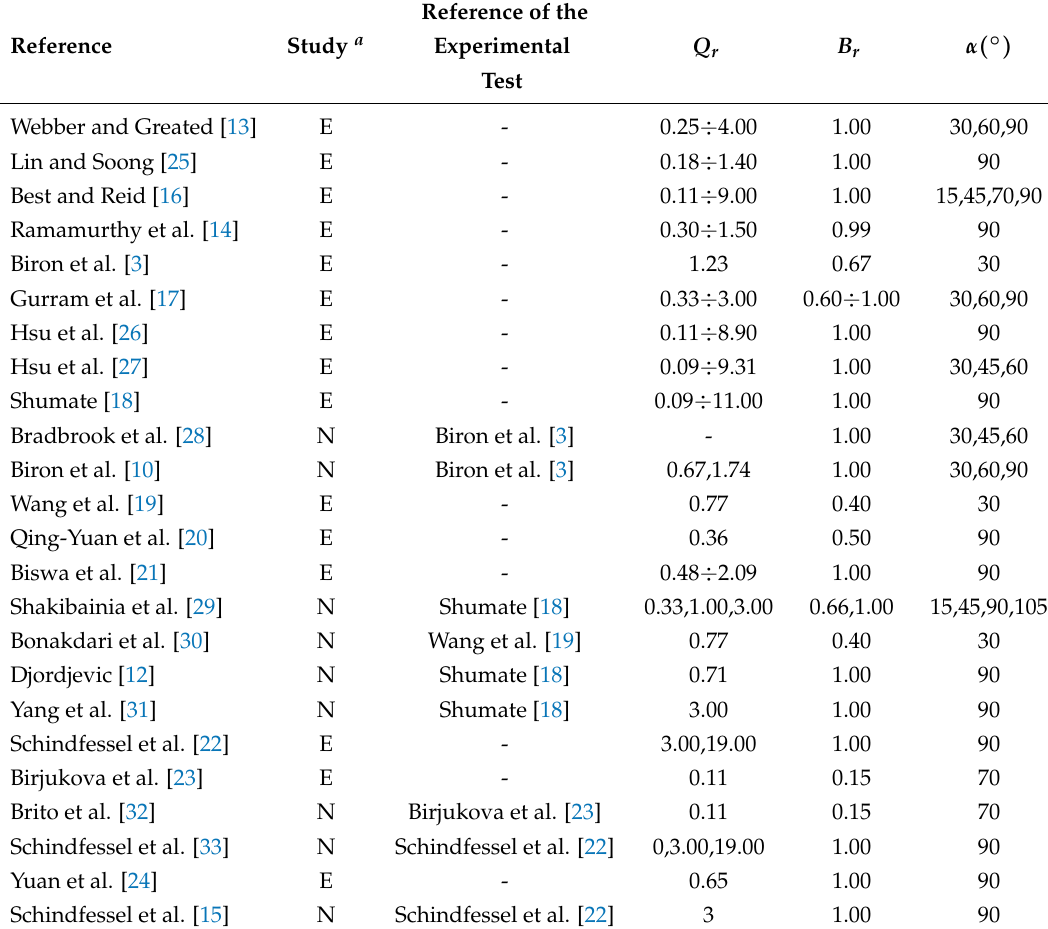
Table 1. Experimental tests and numerical studies on channel confluences in chronological